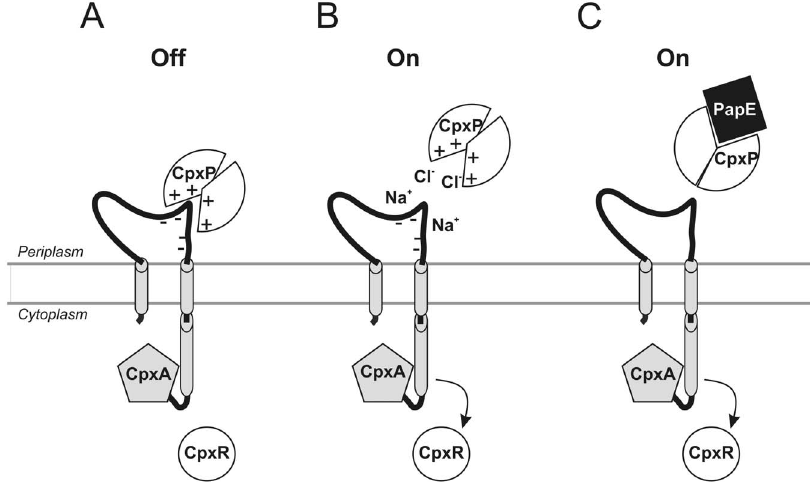
Figure 6. Model depicting CpxP-dependent signal integration by the Cpx-two-component system. (A) Polar interaction between the inner cavity of the CpxP dimer and CpxA keeps the sensor kinase in an ‘‘Off’’ mode. The release of CpxP from CpxA switches CpxA to the ‘‘On’’ mode (B–C). Release of CpxP from CpxA results from a high salt concentration that disturbs the polar interaction between the two proteins (B), or by competing interaction of CpxP with misfolded P-pilus subunits (C) (adapted from [7]).